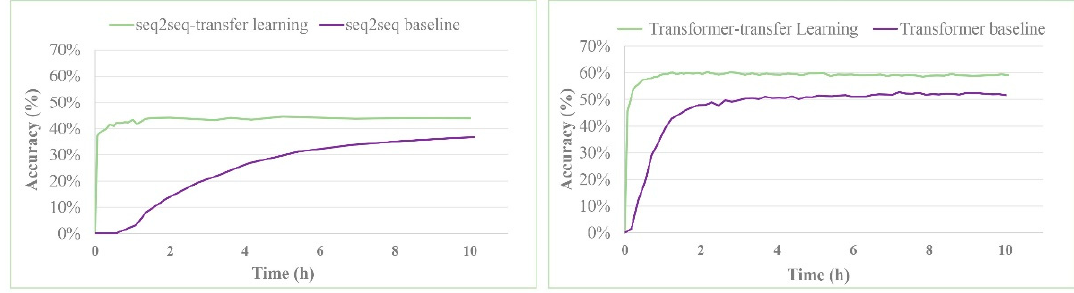
Figure 3. The top-1 accuracies of the seq2seq / seq2seq-transfer-learning and Transformer / Transformer-transfer-learning models as a function of time.